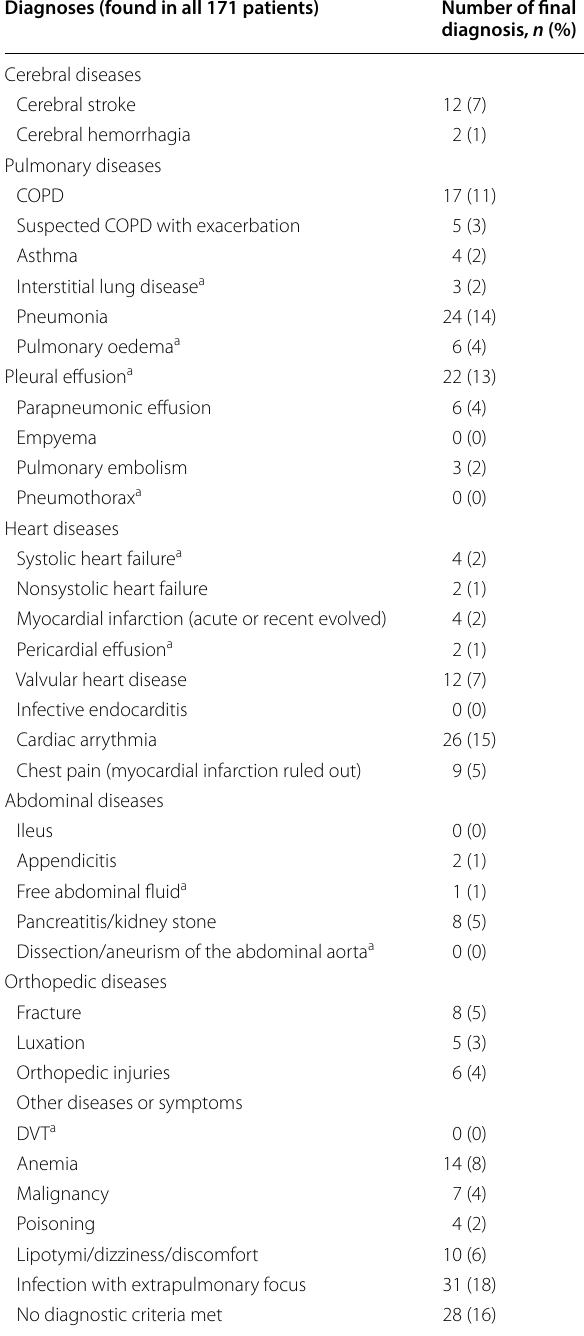
Table 3 Gold standard defined as final diagnoses established by blinded audit of the medical